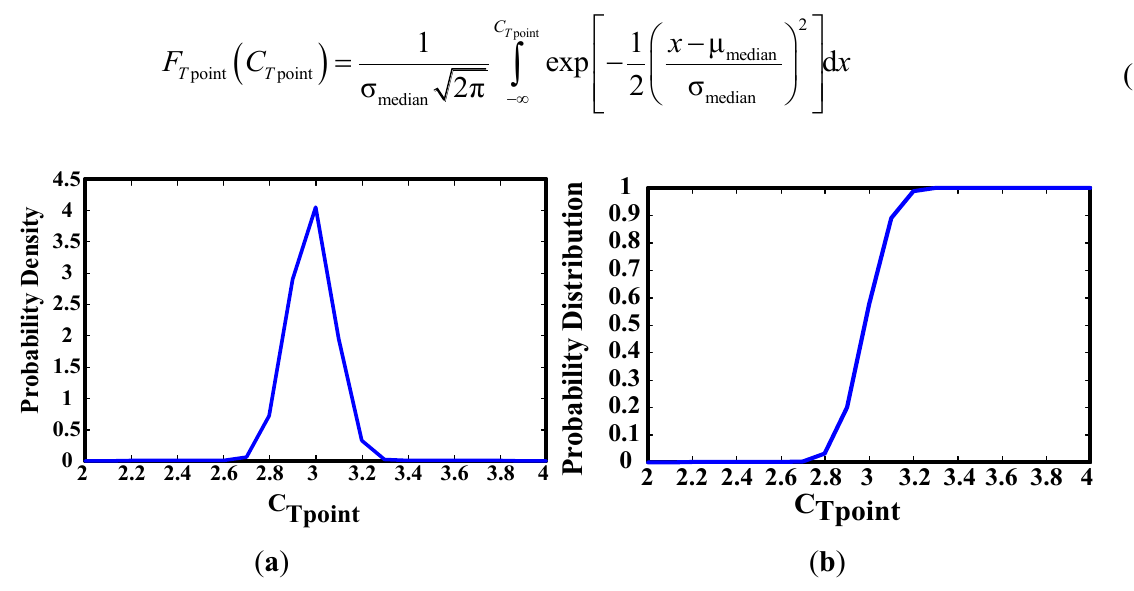
Figure 8. The normal probability density function and the normal distribution function of C T point . ( a ) The normal probability density function of C T point ; ( b ) The normal distribution function of C T point